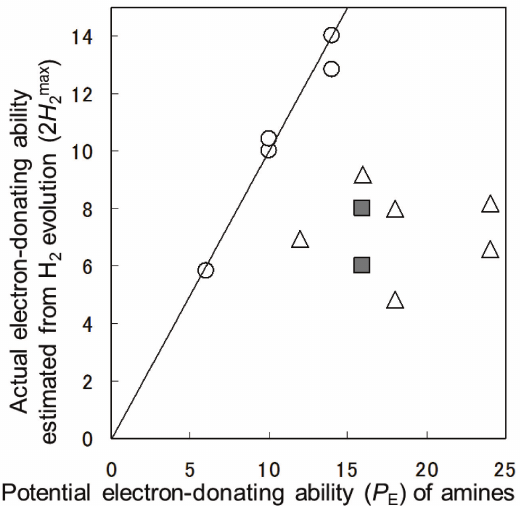
Figure 10. Plots of the actual electron-donating ability (2 H 2max ) against P Pt/TiO -photocatalytic H evolution using 1a – m : Group A ( ○ ), Group B ( ■ ), and 2 2 Group C ( Δ ). A line was 2 H 2max = P . E